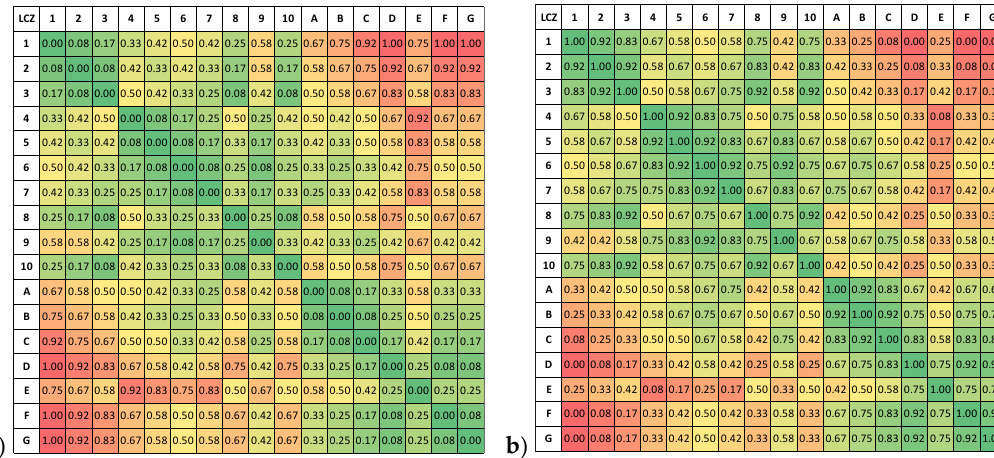
Figure 3. ( a ) Dissimilarity and ( b ) similarity metric for LCZ classes (Appendix A in [4]).